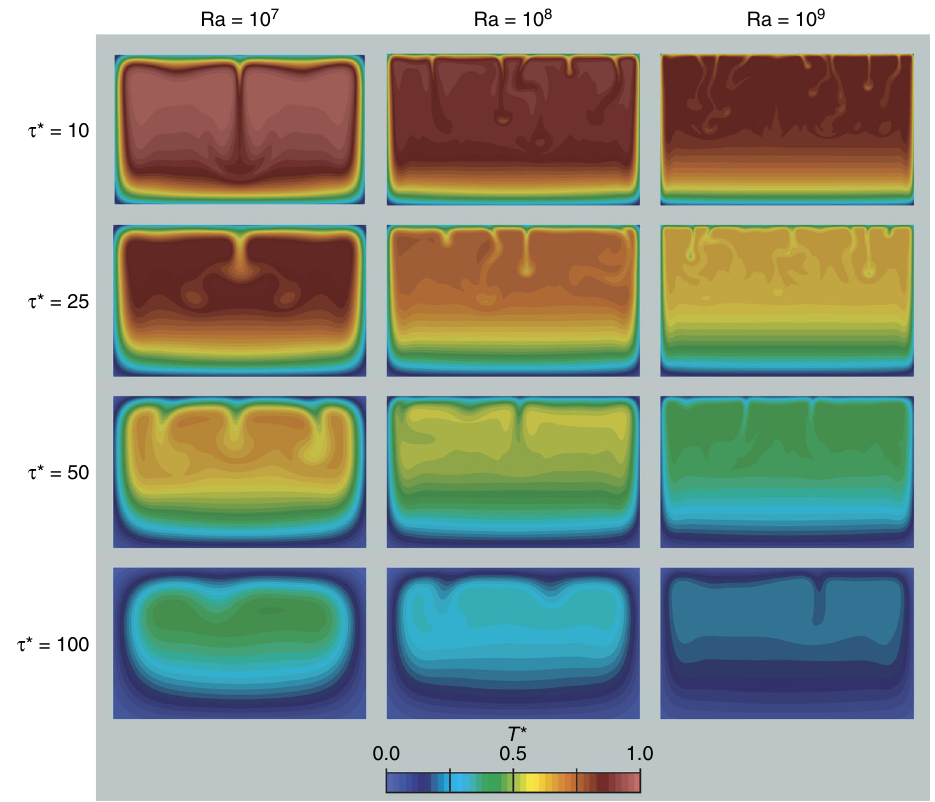
Fig. 9 Thermal evolution of the magmatic system. Snapshots of temperature fi eld in the magma chamber for Ra = 10 7 , 10 8 , and 10 9 at different times τ * . T * is the dimensionless temperature (see Eq.